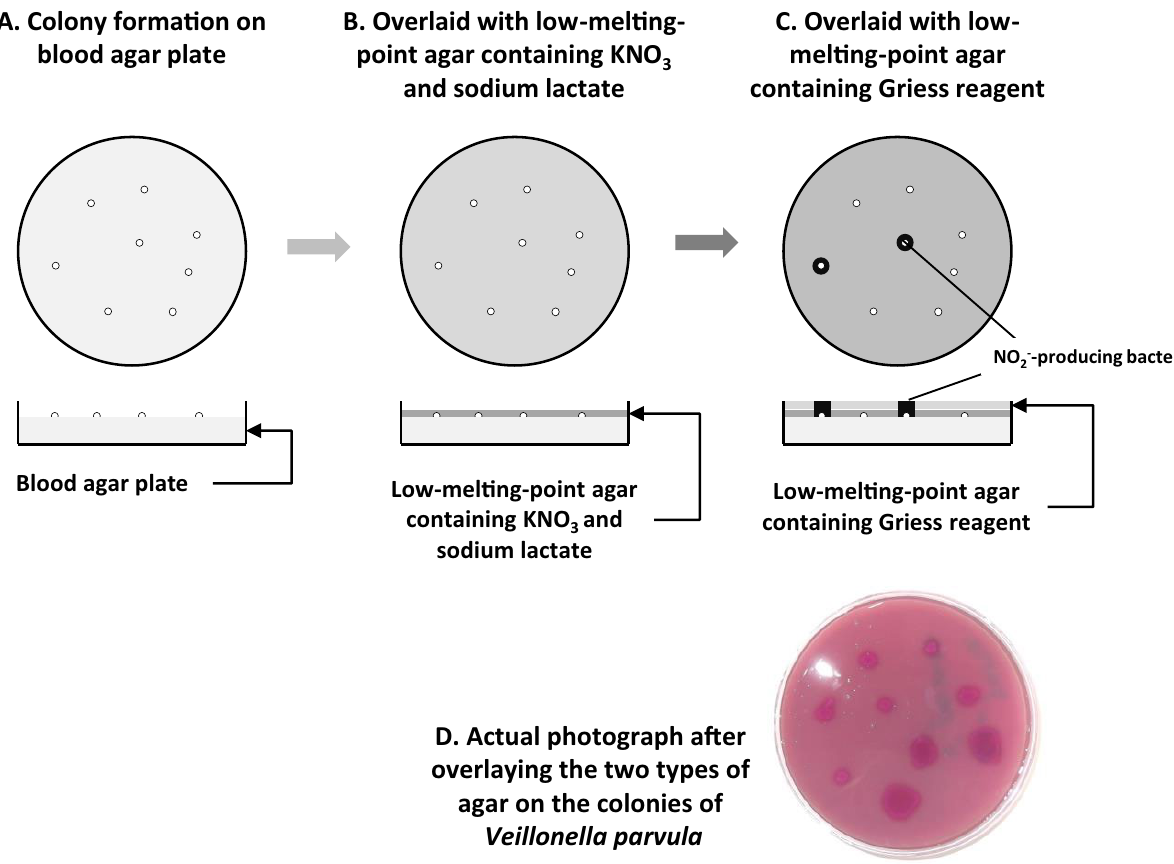
Figure 3. The Griess reagent-containing agar overlay method for detecting NO 2 − -producing